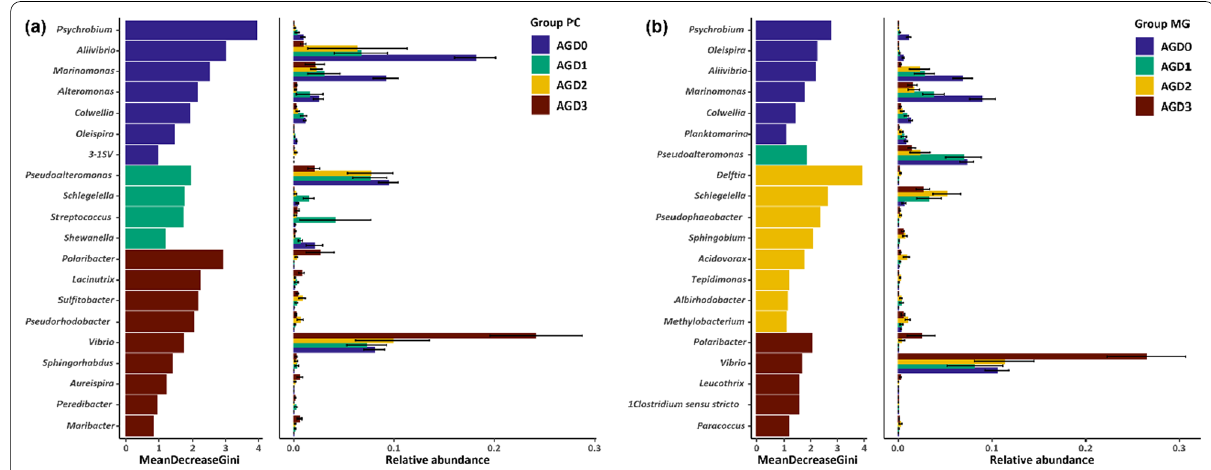
Fig. 8 Top 20 differentially abundant genera in PC samples ( a ) and MG samples ( b ) in starved fish determined by random forest analysis. Mean Decrease Gini indicator represents the importance of each genus in distinguishing between AGD severity scores. Right side of each graph depicts the relative abundance of genera per AGD severity group. Error bars indicate standard